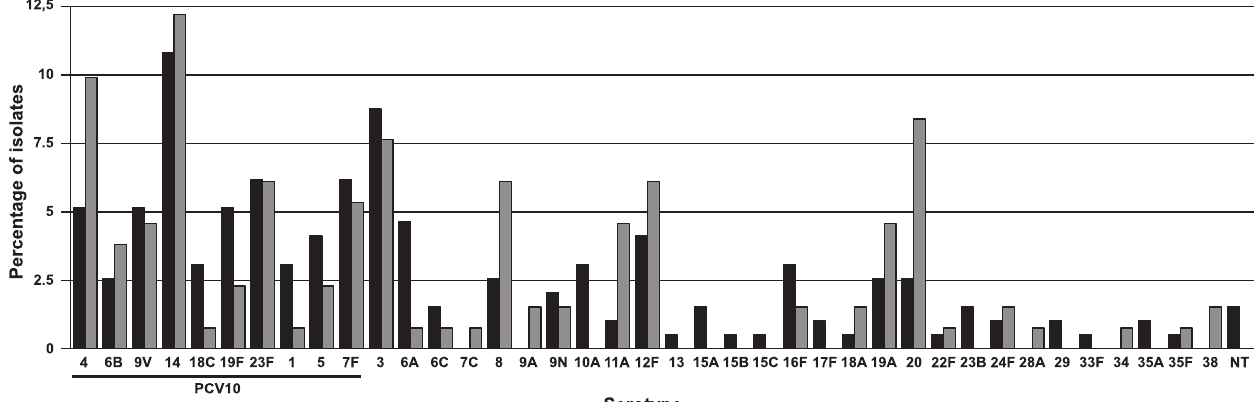
Figure 1. Distribution of serotypes in pre- and post-vaccination period among pneumococci recovered from IPD, during 2007– 2012. Black bars represent pre-PCV10 and gray bars post-PCV10.